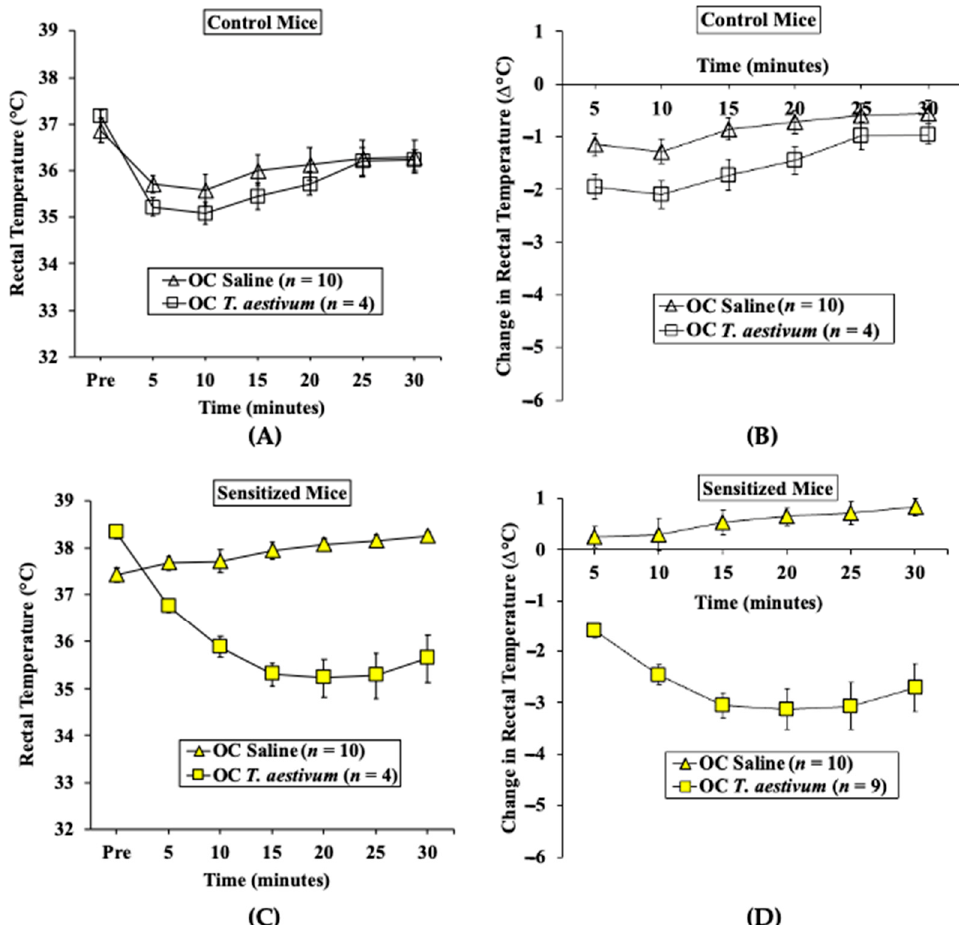
Figure 5. Transdermal sensitization with SSPE is sufficient for eliciting oral anaphylaxis using Triticum aestivum SSPE in Balb/c mice. Mice were sensitized and orally challenged with T. aestivum SSPE or with saline, as described in Materials and Methods. ( A ) Actual rectal temperature at indicated time points in control mice challenged with T. aestivum SSPE or saline. ( B ) Change in rectal temperature at indicated time points in control mice challenged with T. aestivum SSPE or saline. ( C ) Actual rectal temperature at indicated time points in control mice challenged with T. aestivum SSPE or saline. ( D ) Change in rectal temperature at indicated time points in allergic mice challenged with T. aestivum SSPE or saline. Ab: antibody, n : number of mice, OC: oral challenge, SSPE: salt-soluble protein extract.